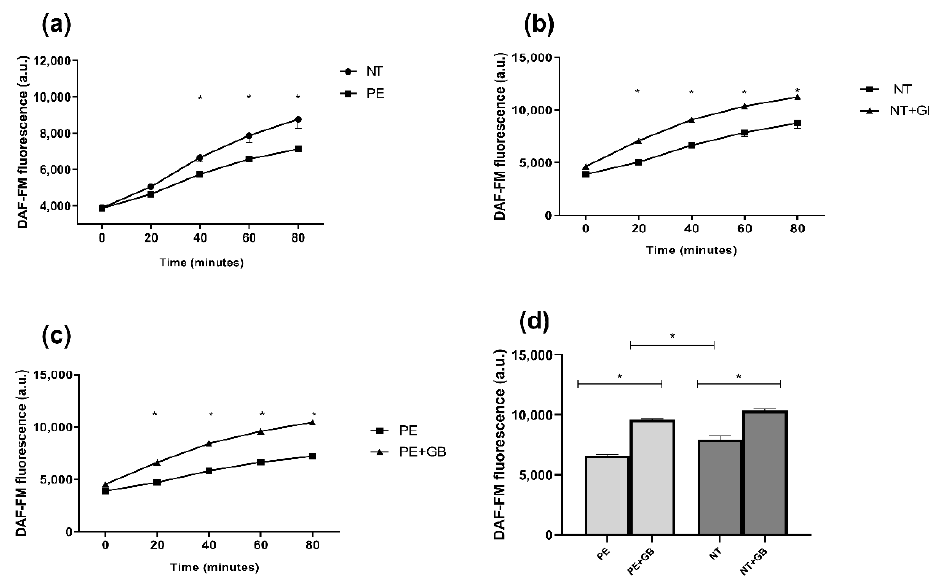
Figure 2. Nitric oxide (NO) fluorescence intensity was measured by DAF-FM for 80 min. Human umbilical vein endothelial cells (HUVECs) were incubated with 20% ( v / v ) pooled plasma from NT (n = 10) and PE (n = 10) ( a ) and then plasma plus GB (100 µM) ( b , c ) for 24 h. Sixty minutes of incubation with GB and plasma are shown in ( d ). Values are represented as means ± SEM. Comparisons between groups were assessed by Two-Way ANOVA followed by Bonferroni’s Multiple Comparison Test ( a – c ) and One-Way ANOVA ( d ) followed by Tukey’s Test. * ( p < 0.05). Nitrite and nitrate levels in supernatant from endothelial cells incubated with a pool of PE plasma presented lower levels of NOx compared with NT-plasma-treated cells (Figure 3). In this group, GB treatment increased NOx levels ( p < 0.05). Comparison between NOx levels produced in HUVEC supernatant and HUVEC+GB also showed an increase in cells treated with GB ( p < 0.05).